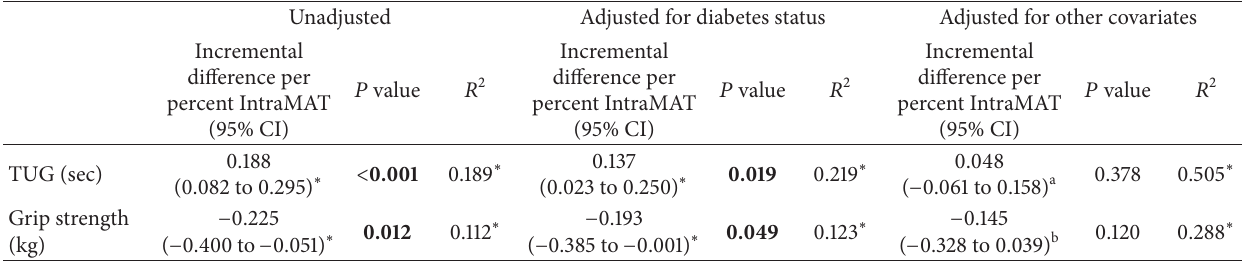
Table 3: Unadjusted and adjusted relationships among IntraMAT, functional mobility, and